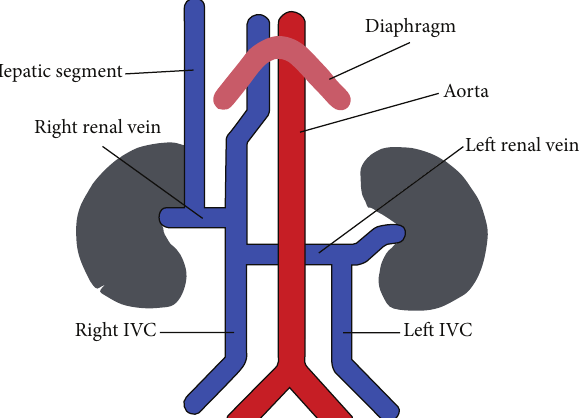
Figure3:SchematicfigureillustratingdoubleIVCwitharetroaortic left renal vein, azygos continuation, and the presence of a hypoplas- tic hepatic portion of the IVC, drained into the right renal